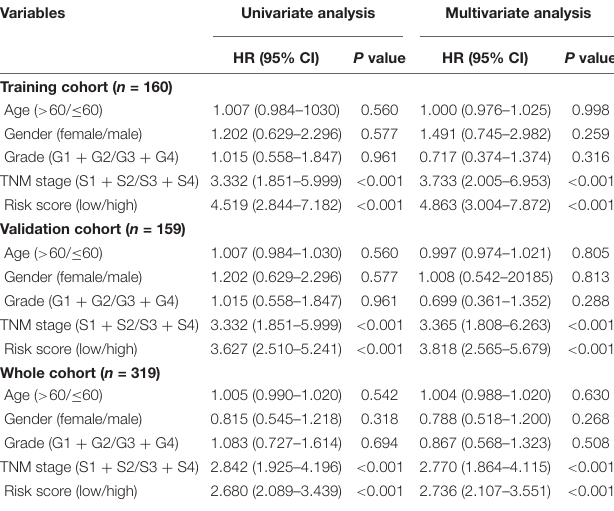
TABLE 3 | Univariate and multivariate Cox regression analysis in each